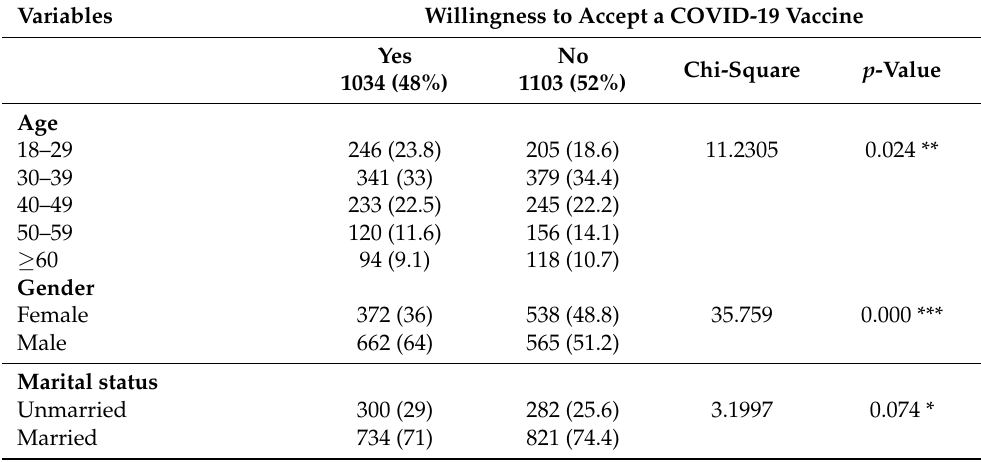
Table 1. Frequency distribution and chi-square analysis of Coronavirus Disease 2019 (COVID-19) vaccine acceptance. SAR, Saudi